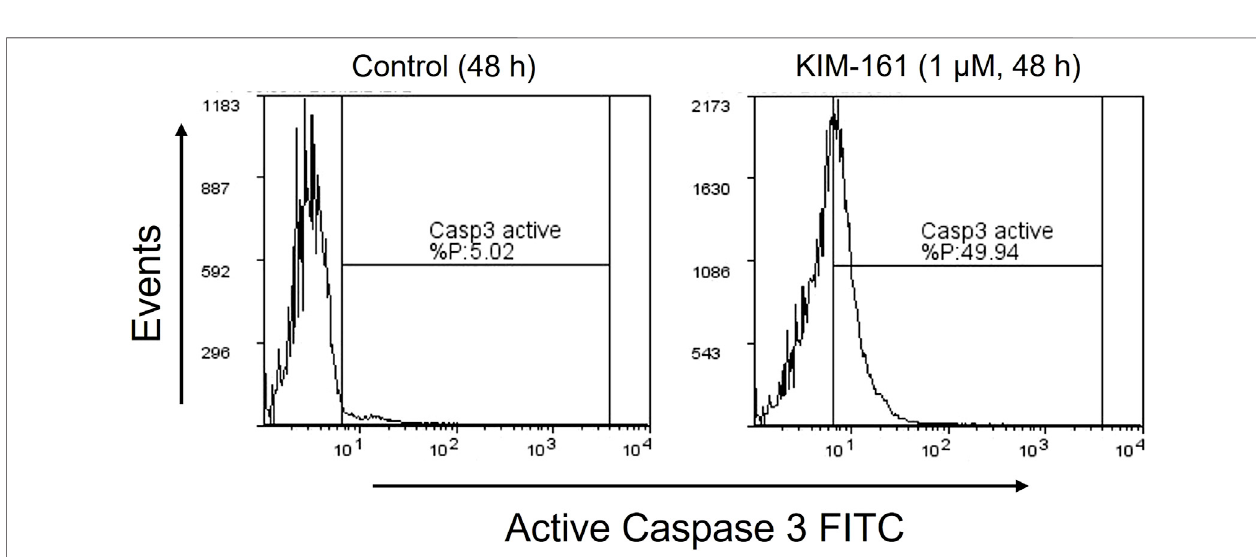
FIGURE 4 | Caspase-3 activity pro fi le after treatment of HL60 cells with KIM-161 (1 µM) compared to untreated cells (control) for 48 h.